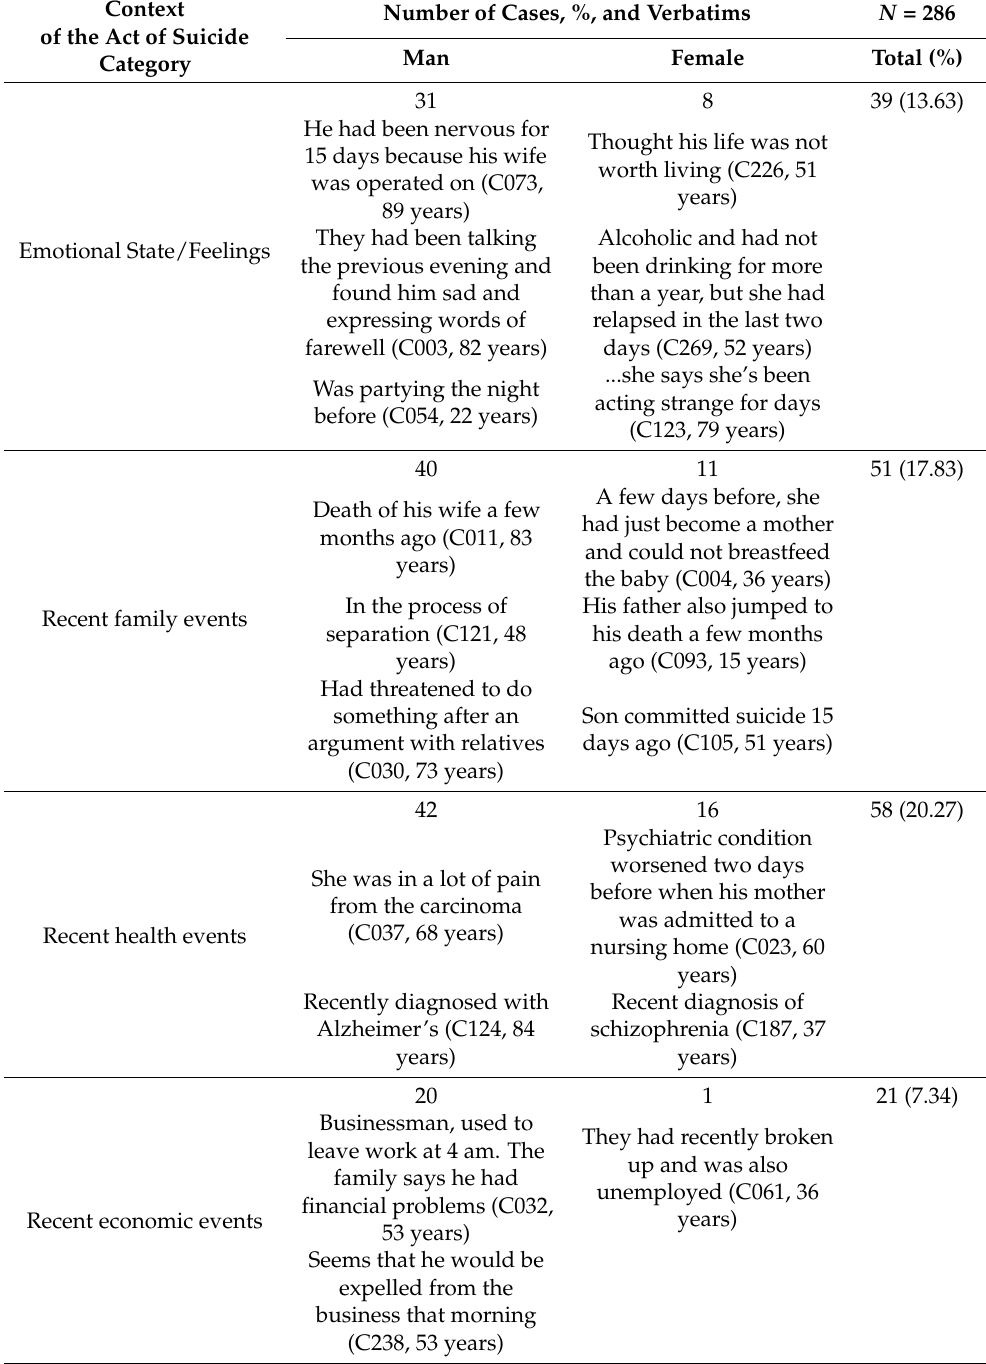
Table 4. Category: Context of the act of suicide. Subcategories, number of cases, percentages, and verbatims of forensic observations in males and